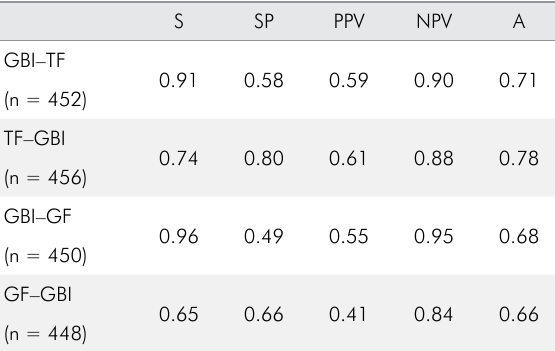
Table 2. Values of sensitivity (S), specificity (SP), positive predictive value (PPV), negative predictive value (NPV), and accuracy (A) when considering GBI as the gold